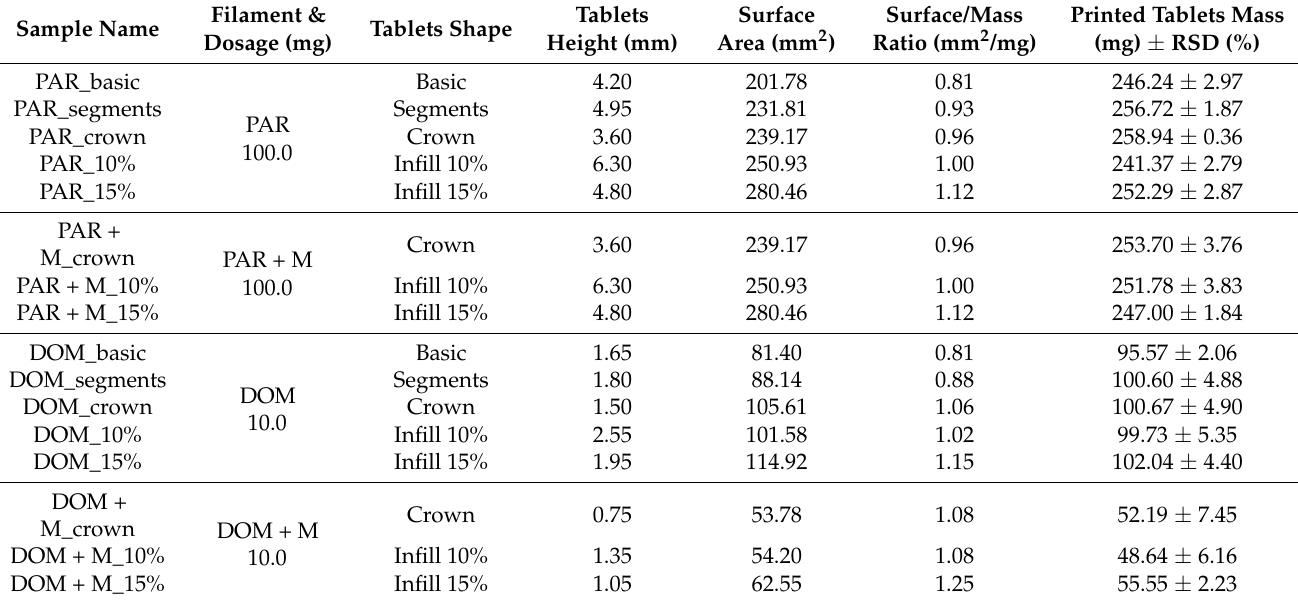
Table 4. Attributes of tablets based on projects obtained by reversed